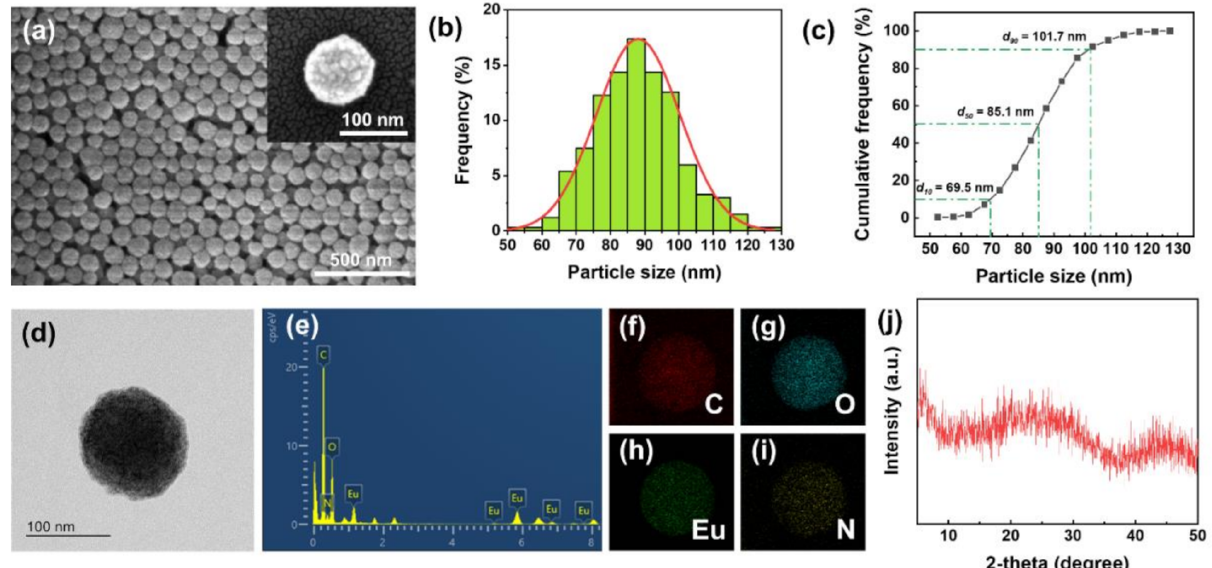
Figure 2. ( a ) SEM images, ( b ) size histogram, ( c ) cumulative frequency distribution, ( d ) TEM image, ( e ) EDX spectrum, ( f – i ) EDX elemental mapping, and ( j ) XRD spectrum of